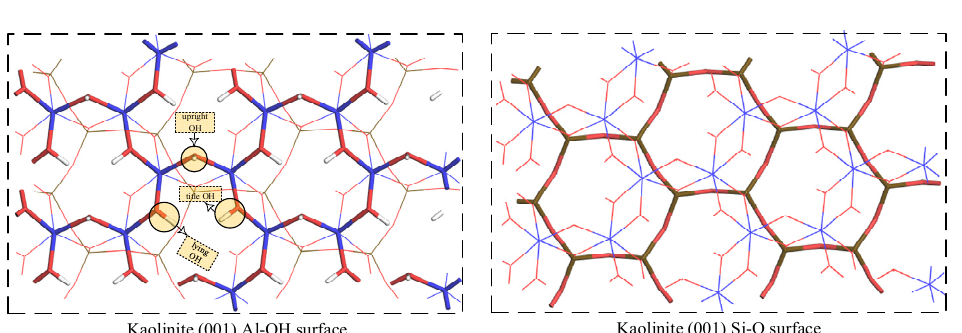
Figure 1. Kaolinite (001) surface model.